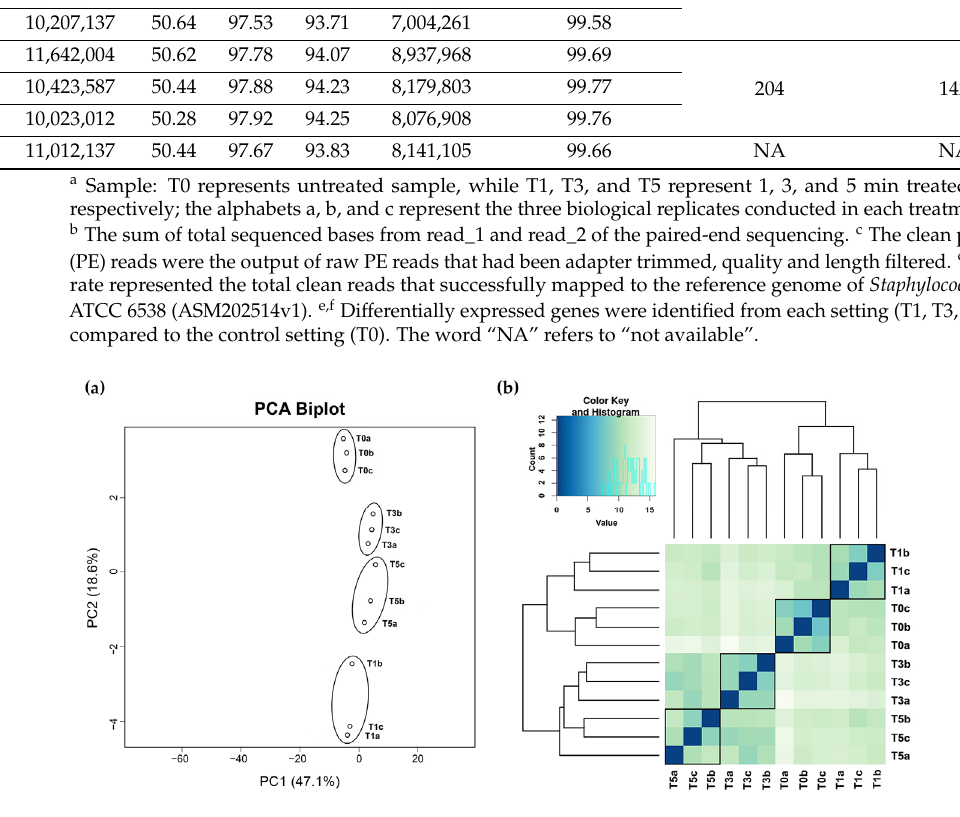
Figure 5. Biological replicates assessment via ( a ) PCA plot and ( b ) heatmap and clustering of sam ‐ ple ‐ to ‐ sample